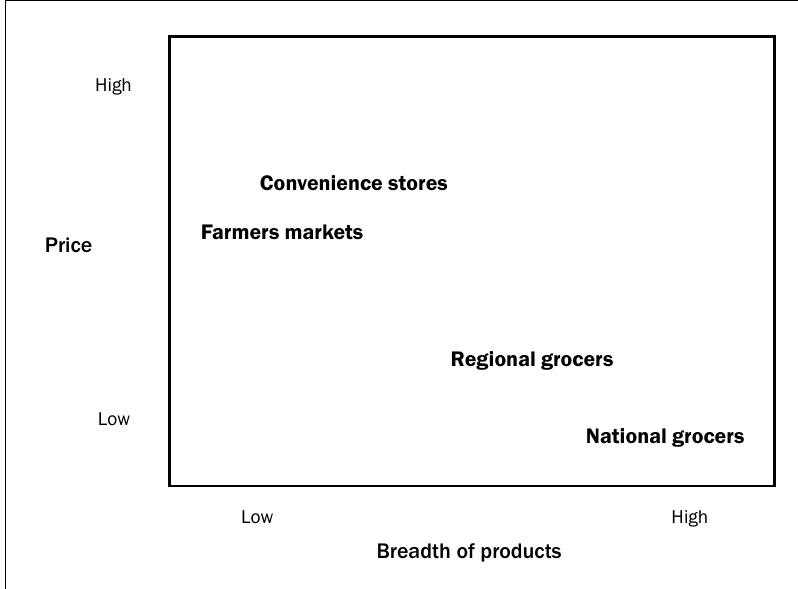
Figure 2. Strategic Group Map: Food Retail